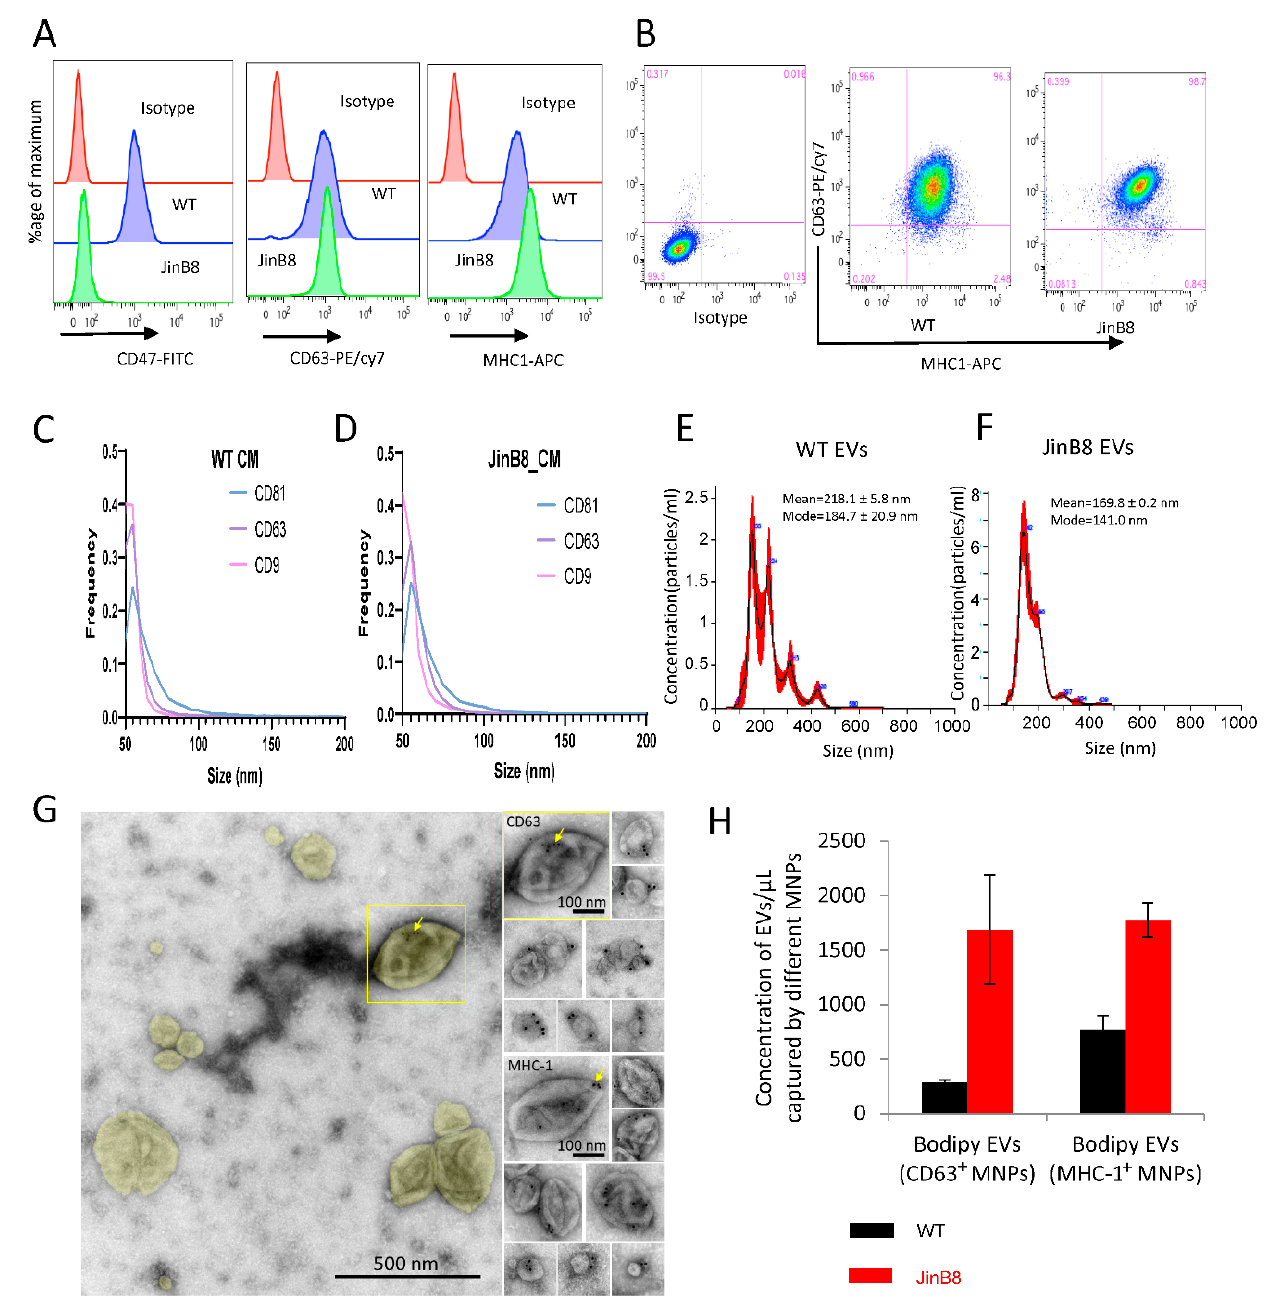
Figure 1. ( A , B ) WT Jurkat and JinB8 T cells were stained using conjugated CD47, CD63 and MHC-I antibodies and analyzed by flow cytometry. ( C , D ) NanoView analysis of size and expression of the tetraspanins CD9, CD63, and CD81 on EVs in concentrated conditioned media derived from WT Jurkat and JinB8 cells. ( E , F ) Size and concentration of EVs purified from WT and JinB8 cells were measured using Nano Sight. ( G ) Negative stain EM of immunogold labeled EVs purified from activated Jurkat T cells. Left , overview of EVs colorized yellow in a typical field of view. The boxed EV is immunogold labeled for CD63 and shown to the upper right in a montage with other CD63-labeled EVs. Lower right , a montage of EVs immunogold labeled for MHC-1. Arrows indicate 10-nm immunogold particles. ( H ) Quantification by flow cytometry of CD63 + and MHC-I + EVs derived from WT Jurkat and JinB8 cells purified using size exclusion chromatography. Data are representative of two independents biological experiments.